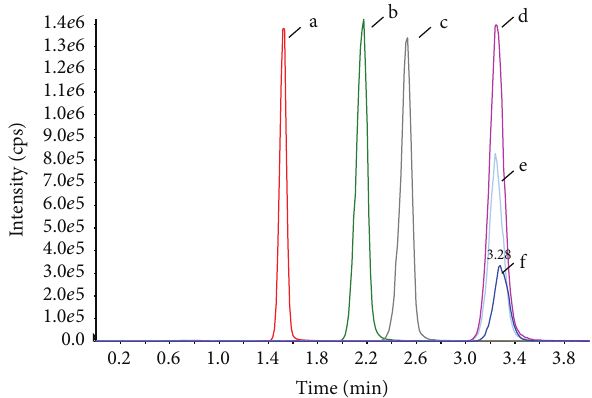
Figure 5: Chromatograms of arachidonic acid in different samples. a: unspiked plasma of Method C, b: unspiked plasma of Method B, c: unspiked sample of Method A, d: spiked plasma of Method D at a concentration of 500 ng/mL, e: unspiked plasma of Method D, and f: arachidonic acid standard, 500